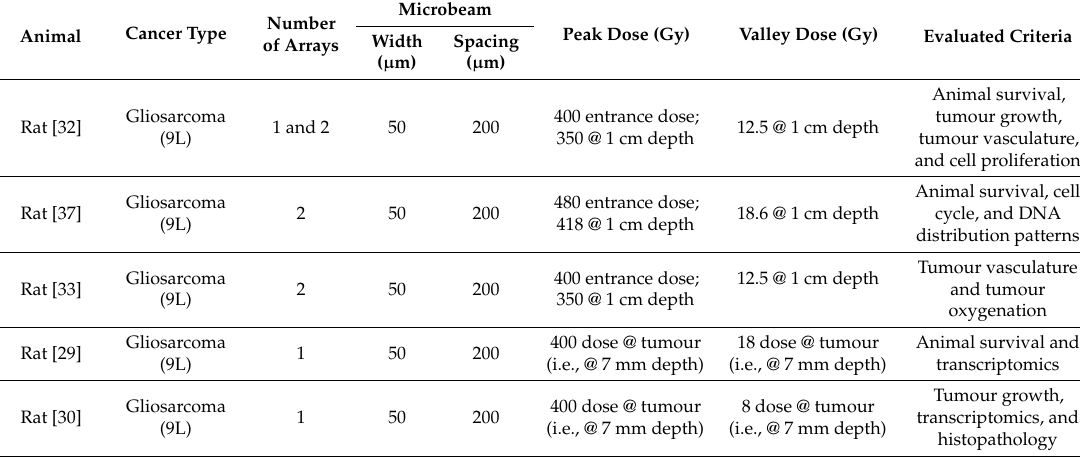
Table 1. MRT parameters used in cancer